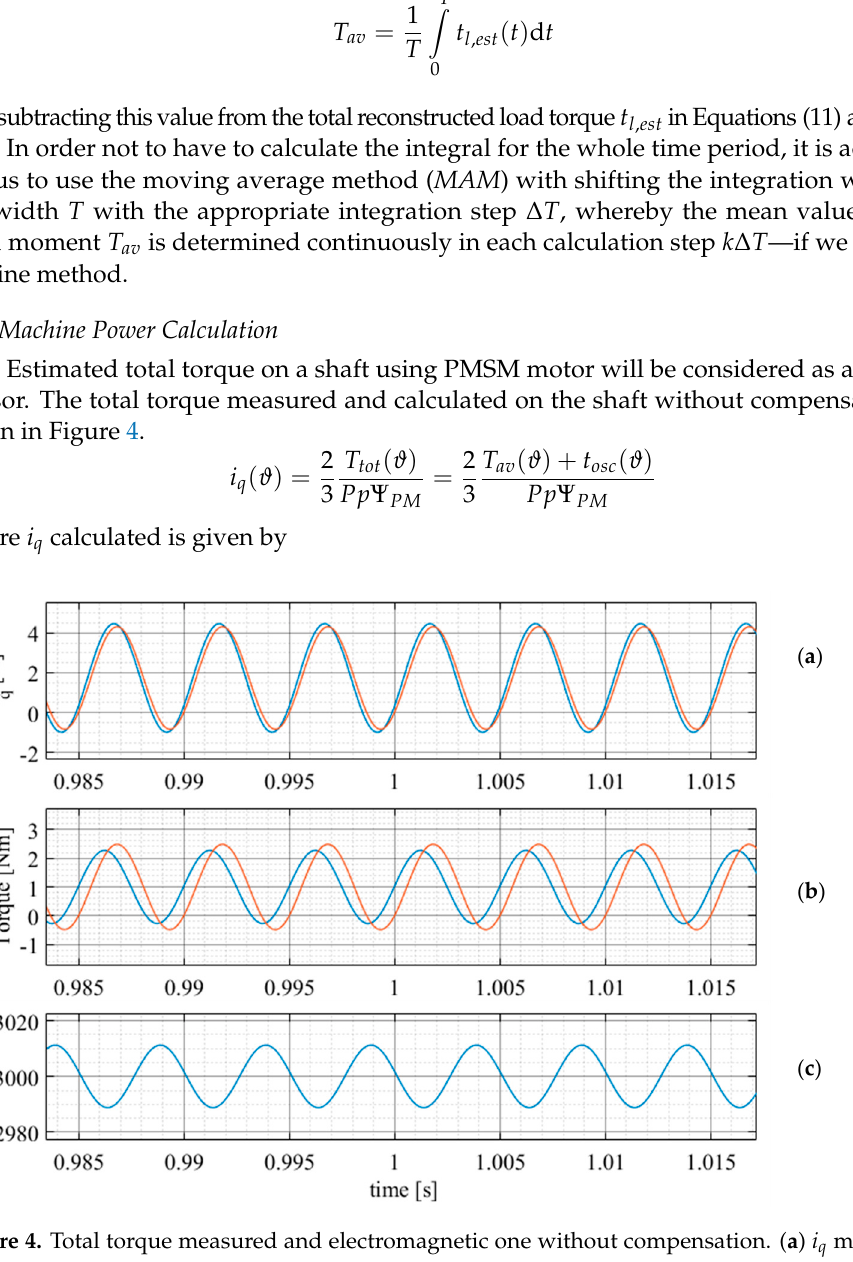
Figure 4. Total torque measured and electromagnetic one without compensation. ( a ) i q measured (orange) and i q generated by speed controller (blue); ( b ) load torque course (blue) and electromagnetic one (orange); ( c ) rotating angular speed.